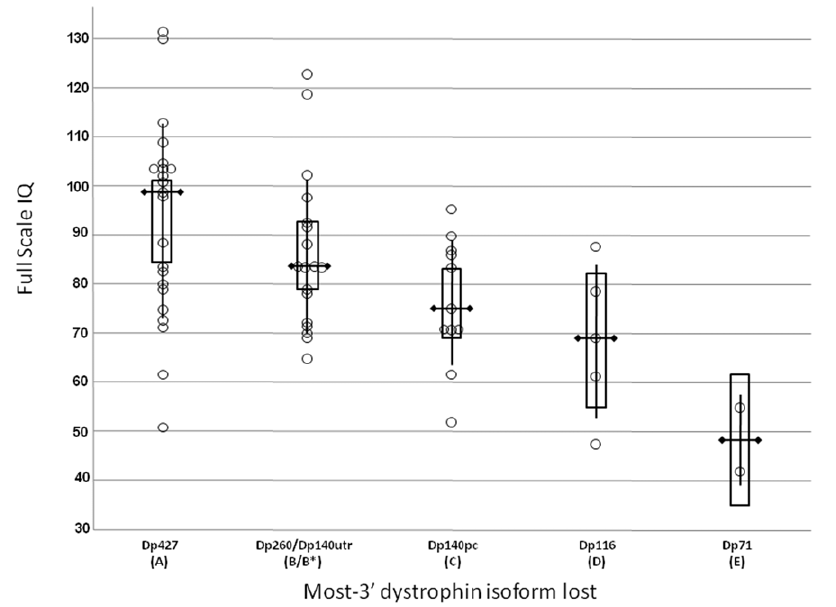
Figure 2. Effect of cumulative loss of dystrophin isoforms on FSIQ. A boxplot representation of patient FSIQ data classified by the most 3 9 dystrophin isoform affected by a mutation. Open circles=patient data points; Vertical lines represent 6 1 standard deviation of the mean; boxes=95% confidence intervals of the mean; horizontal bar=median. doi:10.1371/journal.pone.0008803.g002 PLoS ONE |